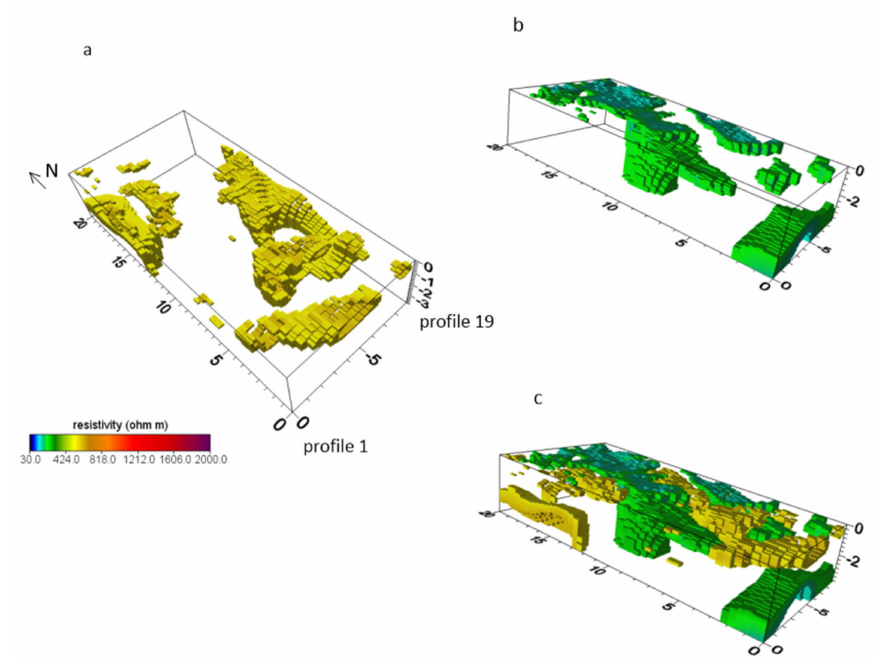
Figure 6. 3D inversion results obtained by selecting resistivity values corresponding to ( a ) walls, ( b ) the circular anomaly and ( c ) both the walls and the circular anomaly. The distances and depths are expressed in m.